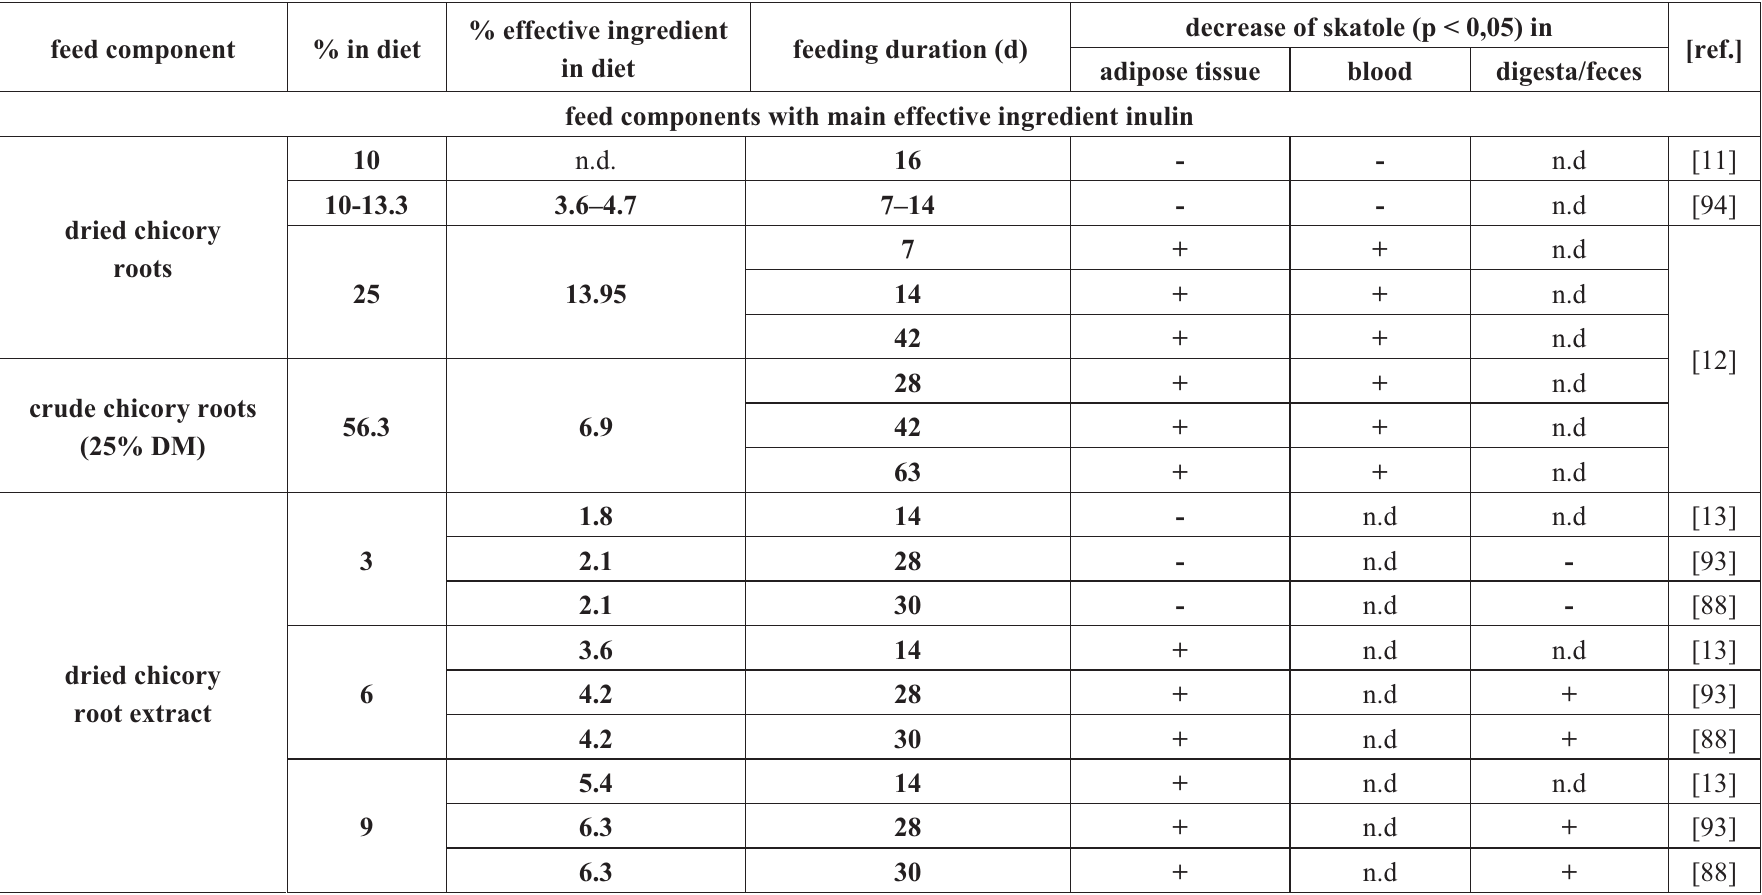
Table 1. Feed components used to influence skatole formation and accretion via fiber supplementation in recent studies and their effectiveness as influenced by the amount in the diet and duration of application. Amounts of feed components and inulin are given as percentage of the fresh matter (DM: dry matter; n.d.: not determined; +: significant decrease in skatole concentration ( p < 0.05); (+): tendency for decrease in skatole concentration ( p < 0.10); - no significant change in skatole